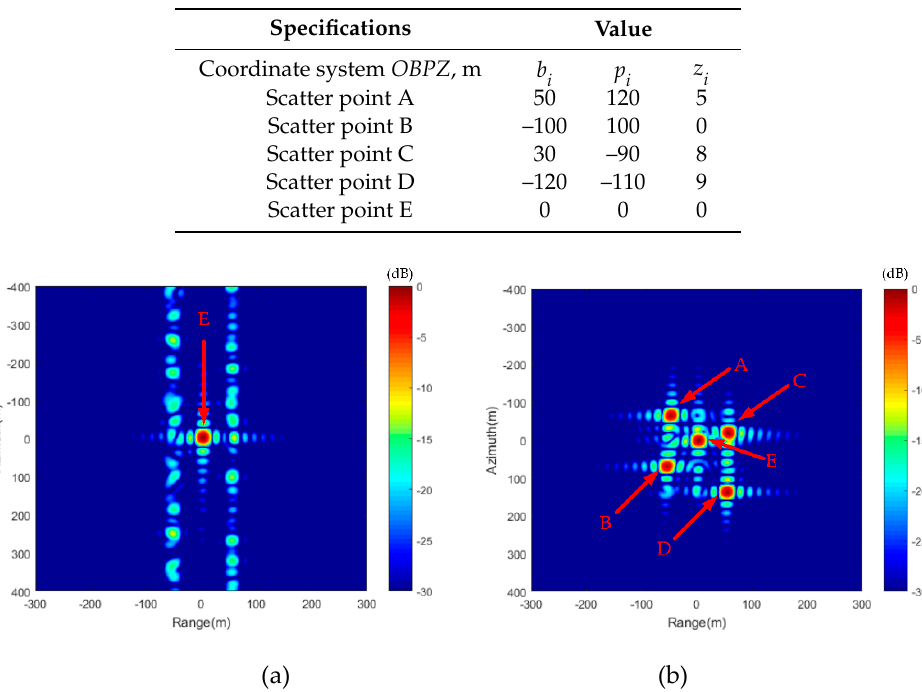
Figure 12. The imaging of a rotating ship: (a) without matching the rotation effect; (b) with the proposed method.